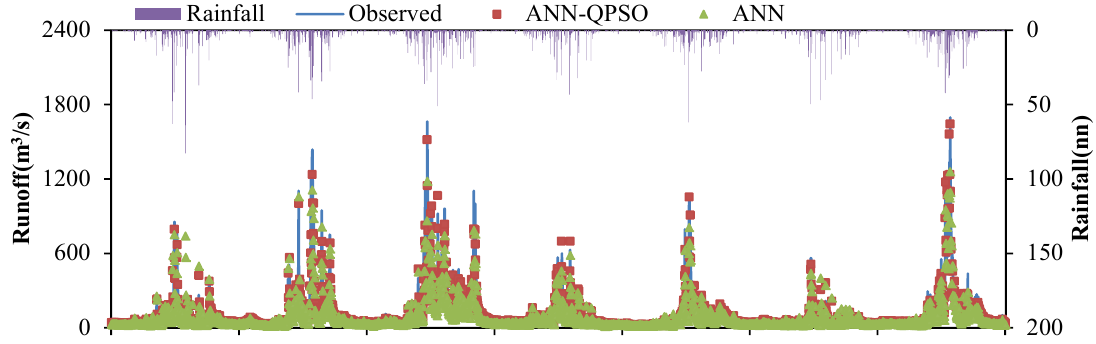
Figure 7. Scatter plots of observed data vs. forecasted data during the testing period. ( a ) ANN-QPSO; ( b ) ANN.